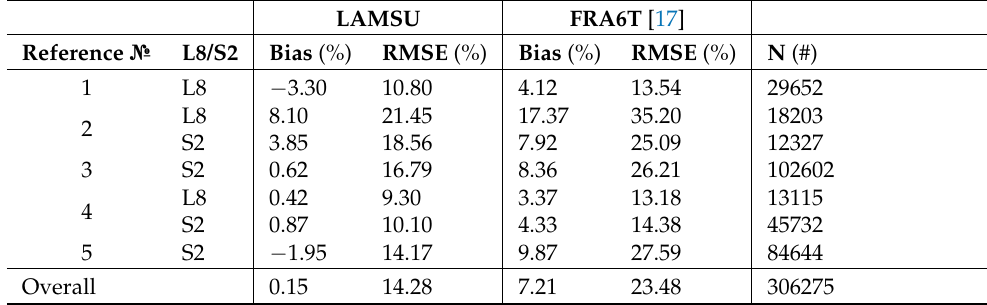
Table 3. LAMSU SCF validation results. Bias is the average SCF bias (LAMSU SCF or FRA6T [17] SCF minus reference SCF) and RMSE is the average SCF root-mean-square error (both) from one million realisations. N is the number of valid pixel-wise comparisons from which the subsets are drawn. More details on the reference data can be found in Table A2 in the Appendix A. L8 and S2 refer to the Landsat 8 OLI (30 m) and Sentinel-2 MSI (20 m) SCF products,